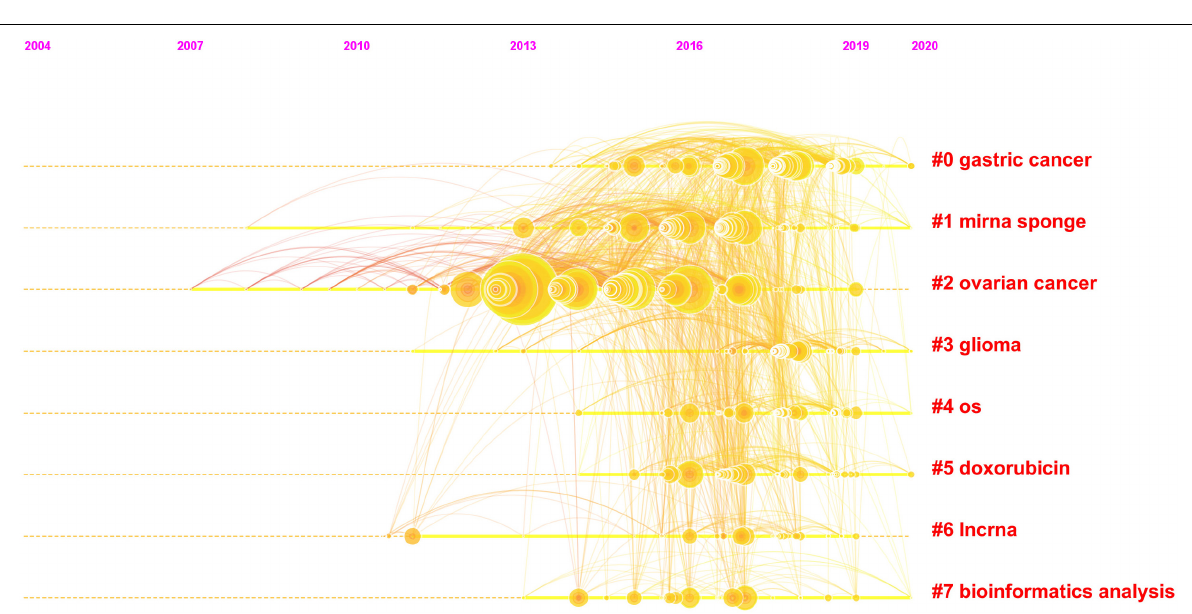
Frontiers in Cell and Developmental Biology |